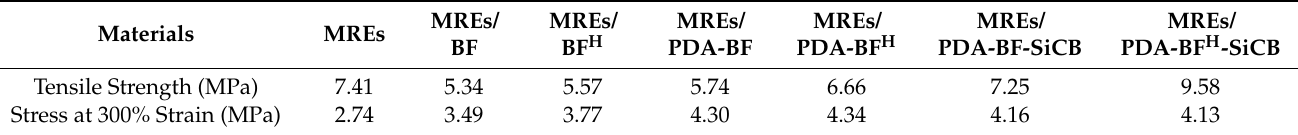
Table 2. Tensile strength values and Stress at 300% strain values of each group of MREs.